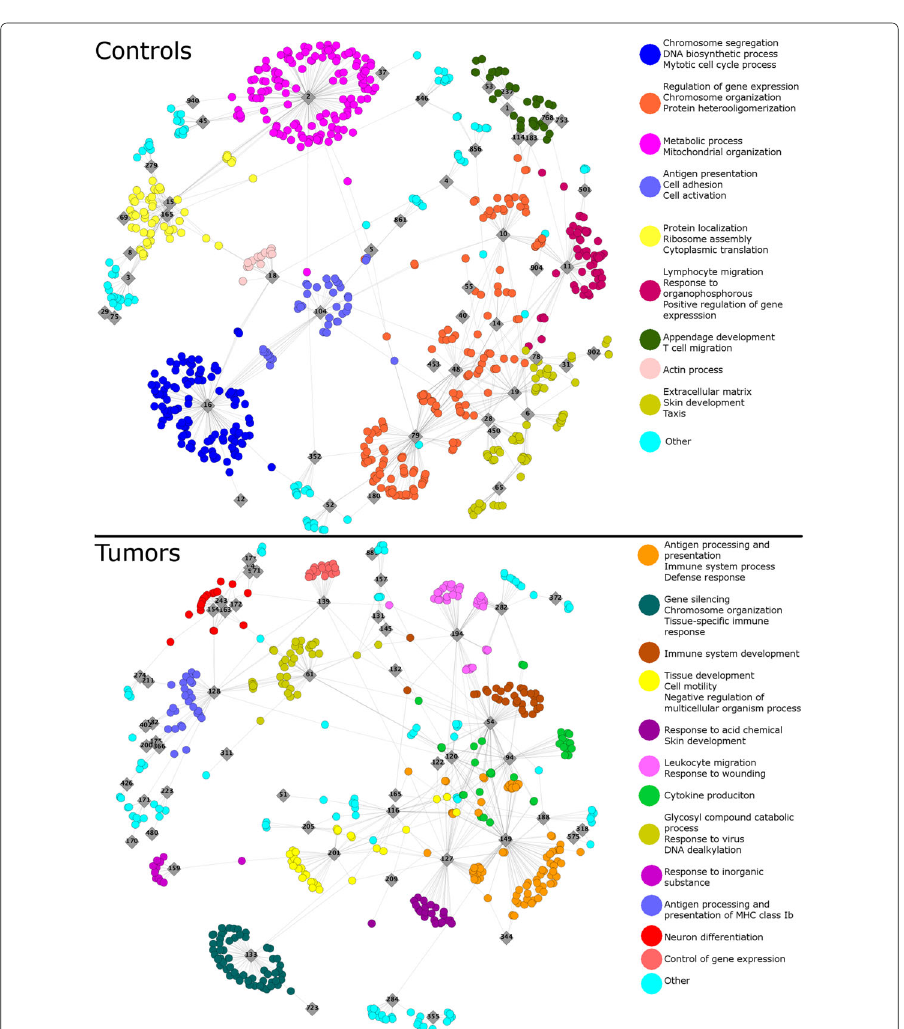
Fig. 7 Bipartite graph of GO term enrichment in network modules. a Control network. b Tumor network. In both networks, grey diamonds represent the module that have enriched GO terms. Colored circles represent GO categories enriched for the linked modules. In some cases, GO categories are connected to more than one module. Colors of GO categories represent a higher category in which each GO term belongs. Colors in a and b are not related. Notice that the categories in A are mainly related to maintenance, meanwhile in B (tumor bipartite network) the majority of categories are related to immunity a well known hallmark of cancer